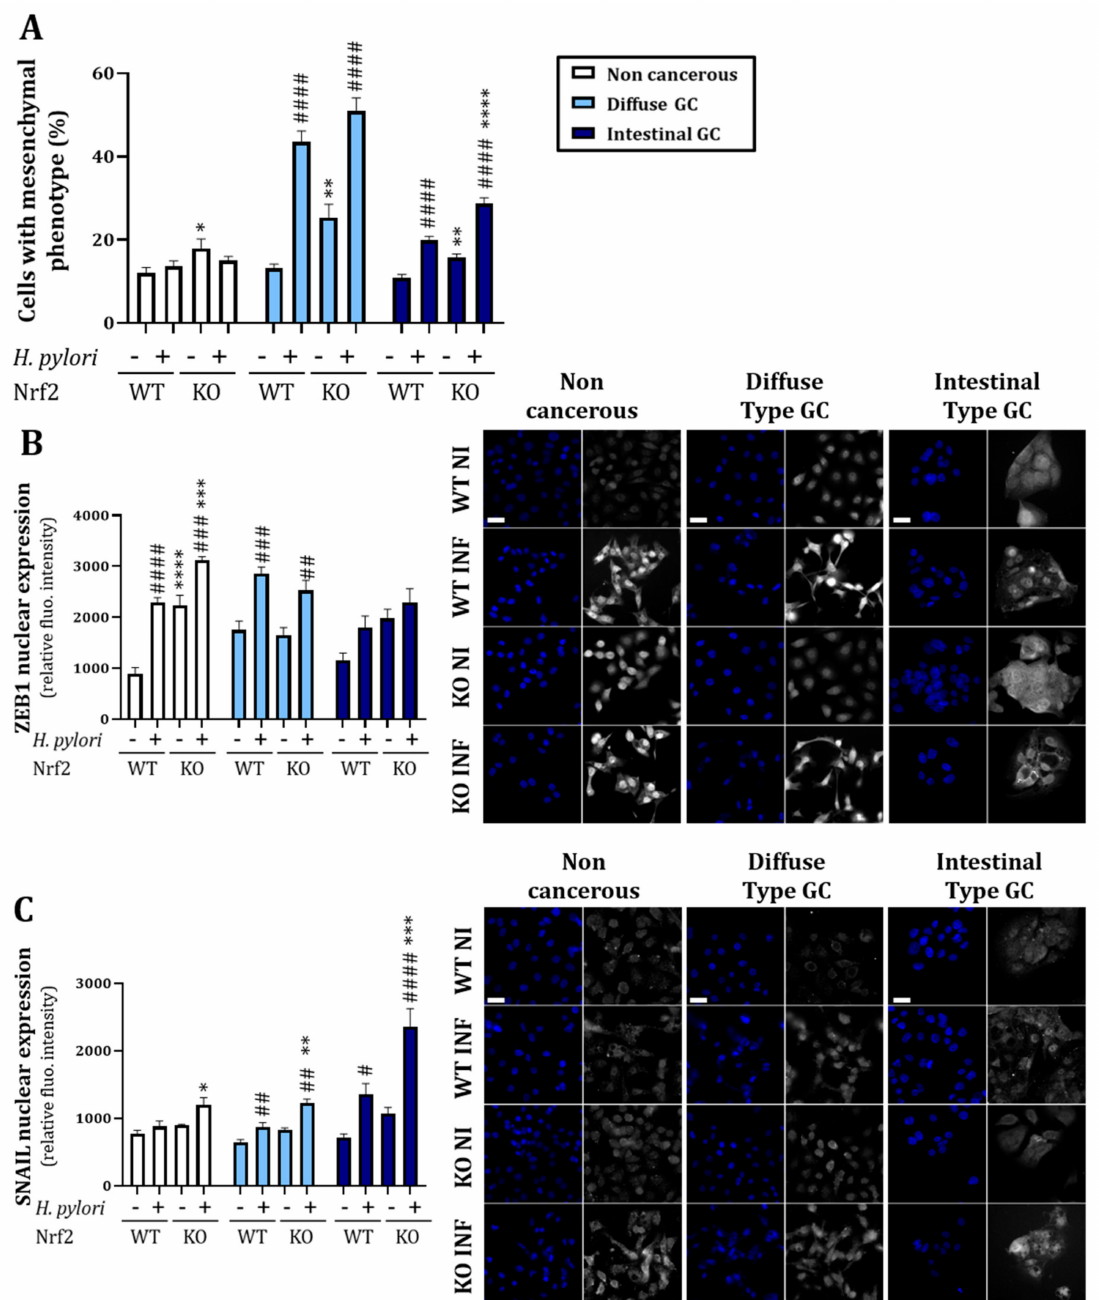
Figure 5. Acquisition of a mesenchymal phenotype associated with an increased ZEB1 and SNAIL nuclear expression is exacerbated in Nrf2-KO cells infected with H. pylori for 24 h. ( A ) Evaluation of the percentage of cells with a mesenchymal phenotype performed by phase contrast microscopy. ( B ) Evaluation of nuclear intensity of ZEB1 by immunofluorescence and representative images with DAPI in blue and ZEB1 in grey. Scale bar: 20 µ m. ( C ) Evaluation of nuclear intensity of SNAIL by immunofluorescence and representative images with DAPI in blue and SNAIL in grey. Scale bar: 20 µ m. WT: Nrf2-wild type. KO: Nrf2-knock out cells. NI: uninfected cells. INF: infected with H. pylori . Mean ± SEM of 3–5 independent experiments. Statistics were performed per cell line with ANOVA followed by a Tukey’s multiple comparisons test. All p -value < 0.05 were considered significant. *: effect of the KO when compared to the WT of the same condition (uninfected or unin- fected). #: effect of the infection when compared to the uninfected of the same condition (WT or KO). * /# < 0.05, ** /## < 0.01, *** /### < 0.001 and **** /#### <